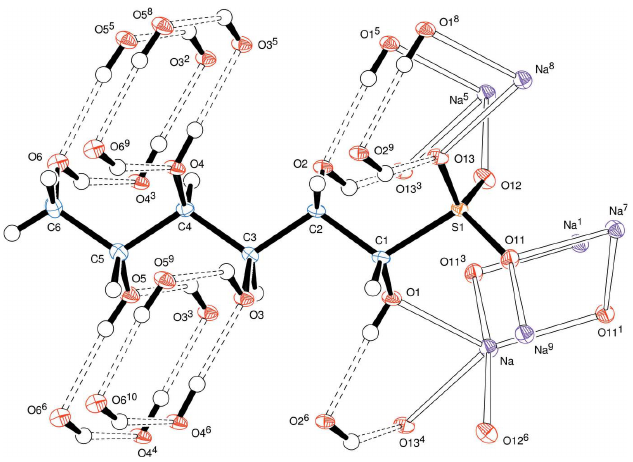
Figure 1 View of the d -mannose–NaHSO 3 adduct, indicating the atom-numbering scheme. All sodium coordination contacts and hydrogen bonds involving the atoms of the sugar adduct are indicated. Displacement ellipsoids are drawn at the 50% probability level. Symmetry codes: (1) 1 (cid:3) x , y (cid:3) 1 2 (cid:3) z ; (2) 1 + x , y (cid:3) 1, z ; (3) x , y (cid:3) 1, z ; (4) x (cid:3) 1, y (cid:3) 1, z ; (5) 1 + x , y , z ; (6) x (cid:3) 1, y , z ; (7) 1 (cid:3) x , 1 + y , 2 (cid:3) z ; (8) 1 + x , 1 + y , z ; (9) x , 1 + y , z ; (10) x (cid:3) 1, 2 1 + y , z